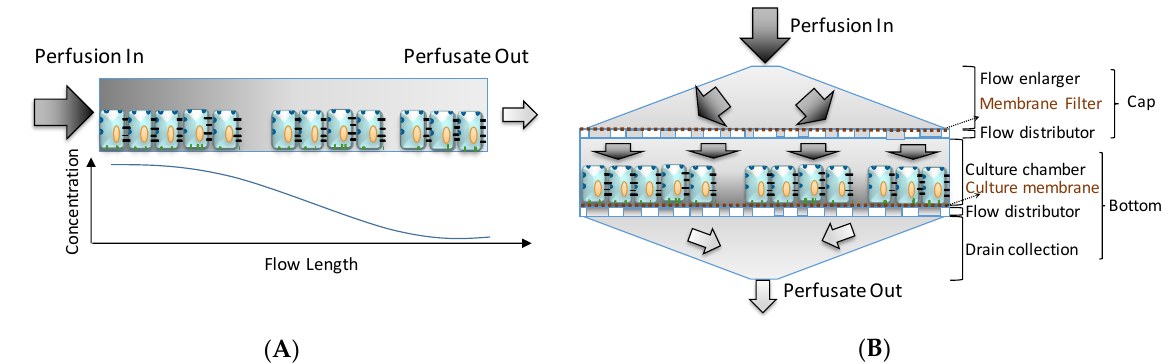
Figure 1. Horizontal- versus vertical-flow: ( A ) Horizontal flow brings an intrinsic gradient concentration when there is an absorption by the cells along the perfusion path. ( B ) Vertical-flow bioreactor distributes the perfusion evenly across the culture area, and makes the perfusate reach the cells on the same plane simultaneously with the original media concentration. (Illustration only, not draw on scale).